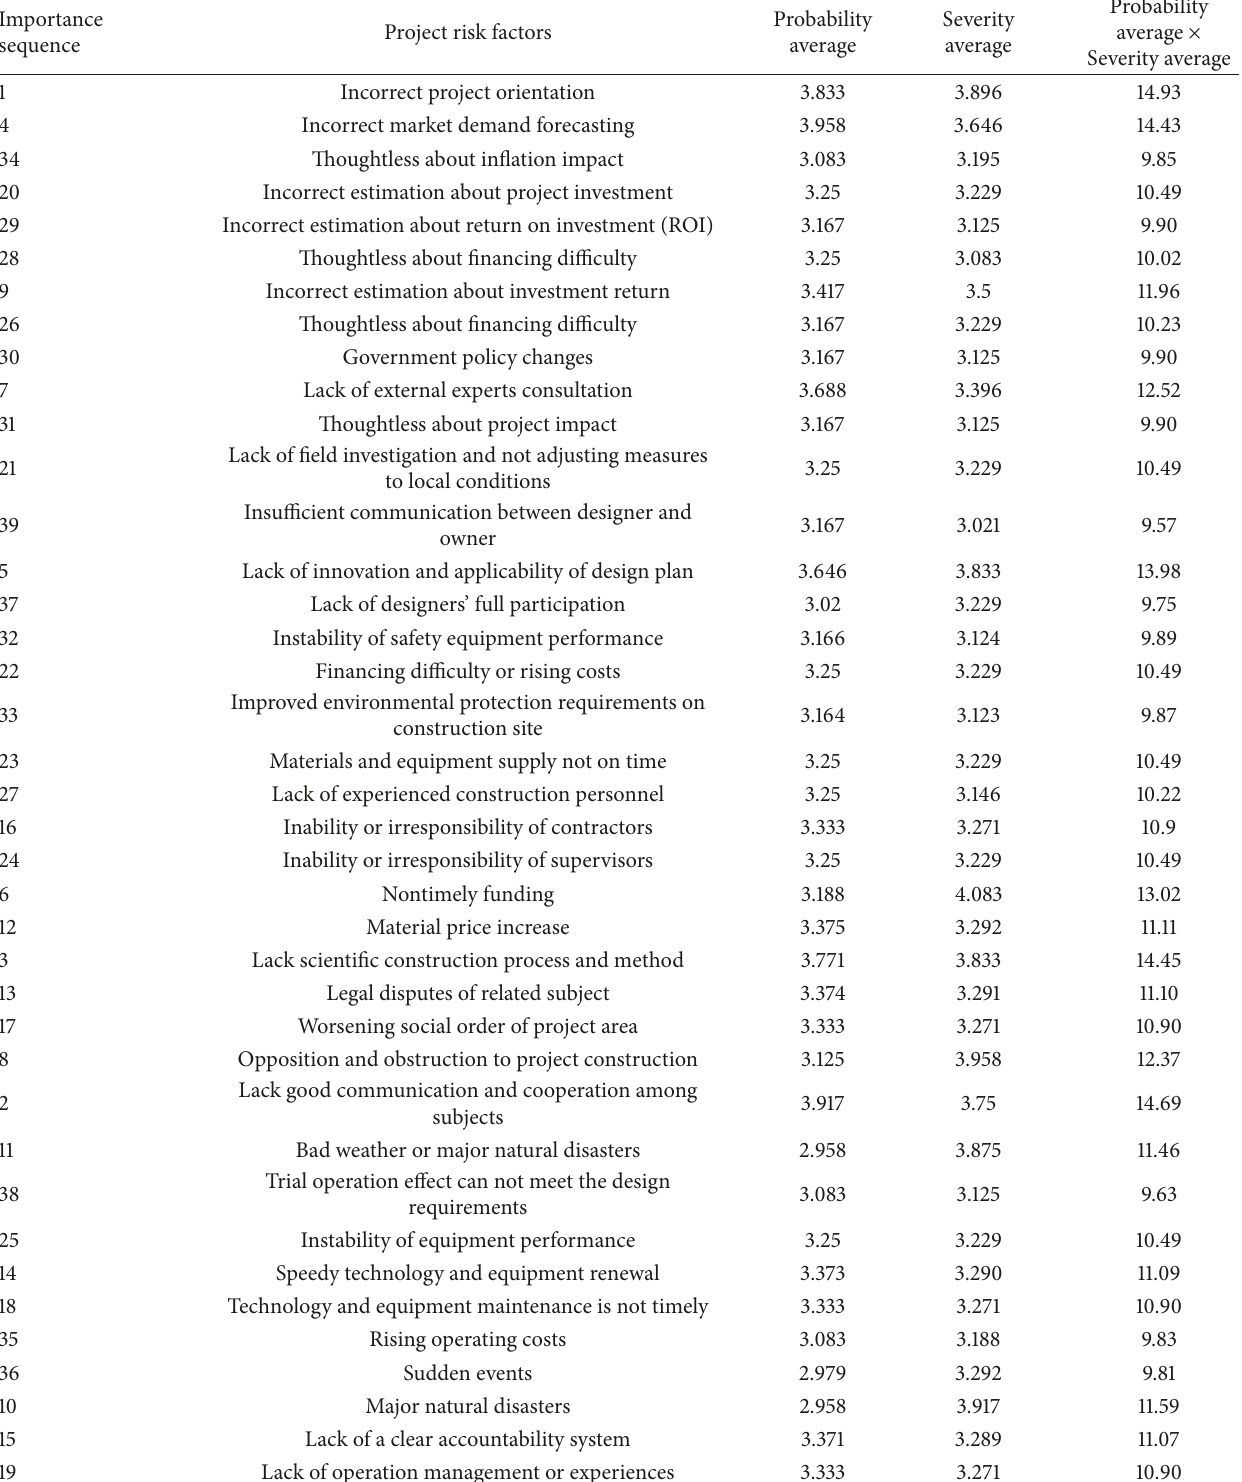
Table 3: Main risk factors sequence through the whole life cycle of a major infrastructure